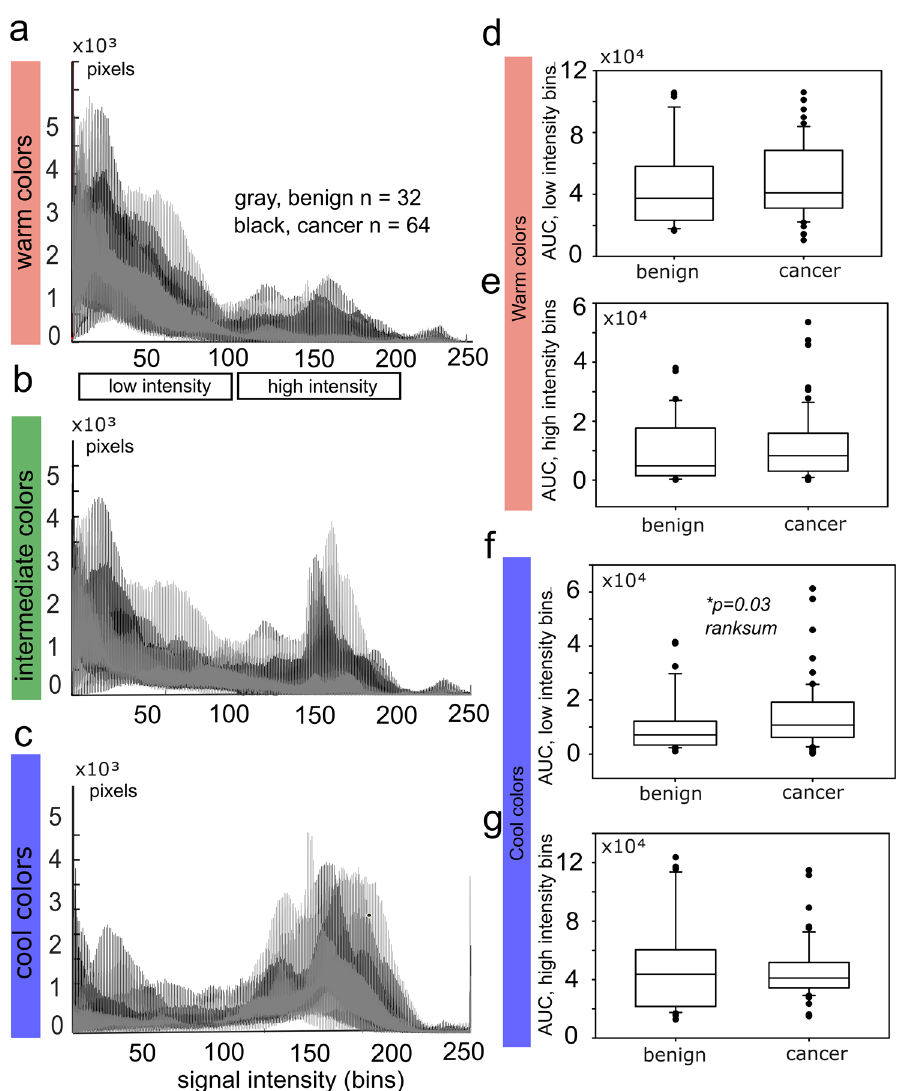
Figure 4. SWE histogram metrics. Cumulative histogram plots for the ( a ) warm colors, p = 5.5 × 10 − 8 , Kolmogorov–Smirnoff test, ( b ) intermediate colors, p = 0.0258, Kolmogorov–Smirnoff test, and ( c ) cool colors, p = 1.36 × 10 − 4 , Kolmogorov–Smirnoff test. ( d – g ) Area under curve (AUC) was calculated for the low-intensity bins (15–100) and the high-intensity bins (100–200). Normality was rejected with Shapiro–Wilk test. The AUC of benign to malignant tumor was compared with Mann–Whitney rank sum test. ( f ) Statistical significance was proven for the low-intensity bins of the cool colors, reflecting a reduction of soft-tissue components, p = 0.03, benign n = 32; cancer n = 64.